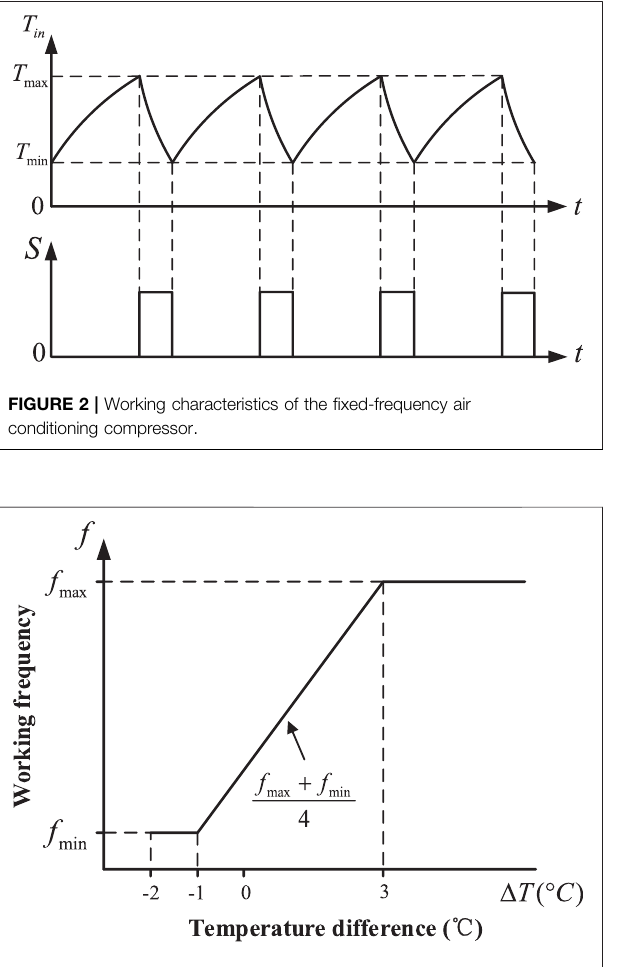
FIGURE 3 | Speed characteristics of the inverter air conditioning